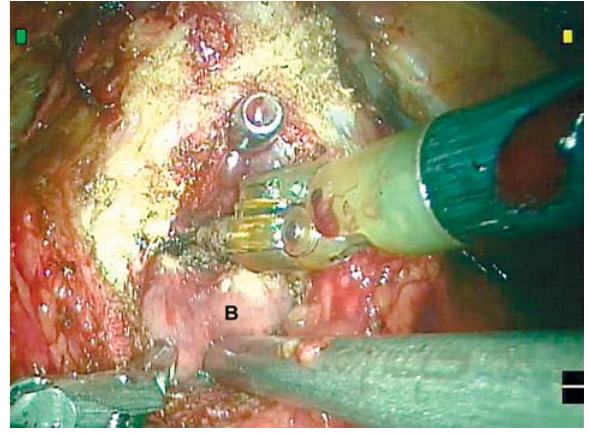
Figure 6 – The vas (V) is retracted cephalad exposing the ipsilateral seminal vesicle (SV) and Denonvilliers’ fascia (D) after complete dissection of the bladder